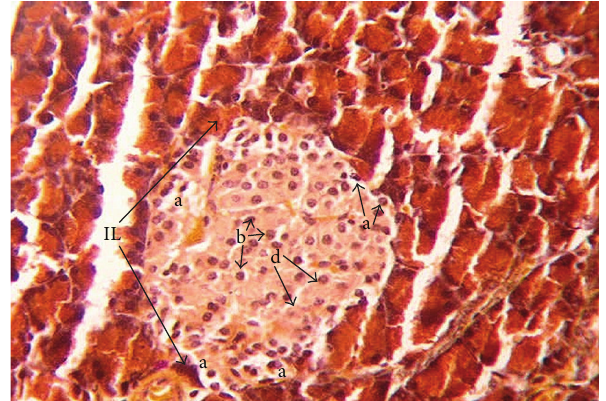
Figure 3: Photomicrograph of pancreas section of normal rat offspring after one week of birth. Islets are intact and larger than after birth with higher numbers of beta (b) cells and fewer numbers of alpha (a) cells. Pd: pancreatic ductile; IL: islets of Langerhans; pa: pancreatic acini ( × 400).